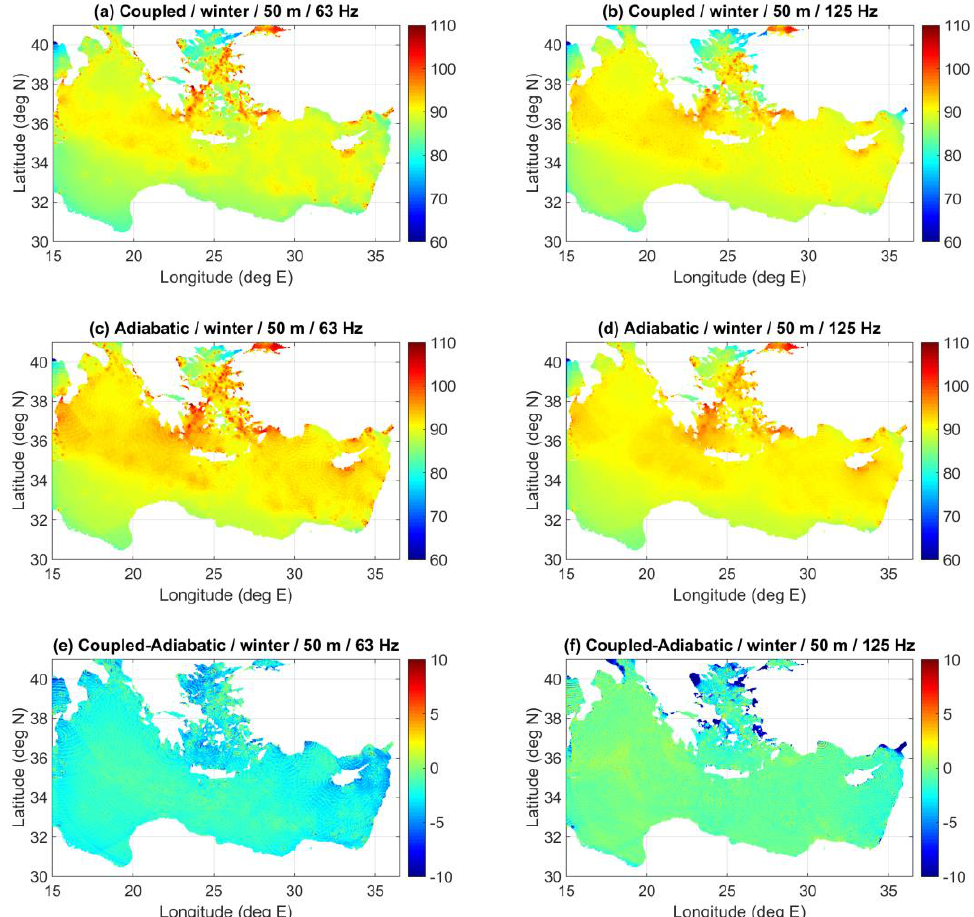
Figure 11. Noise distribution (dB re 1 µ Pa 2 /Hz) in the Eastern Mediterranean Sea at a depth of 50 m